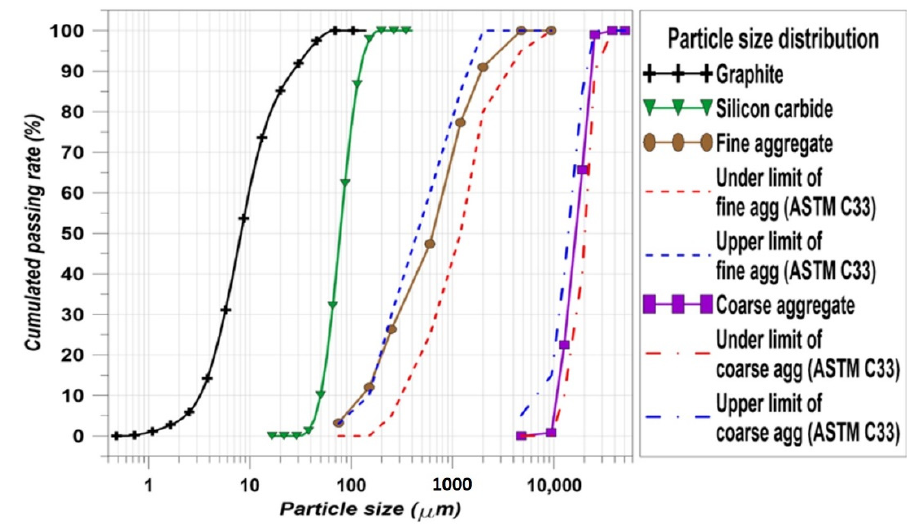
Figure 2. PSDs of the graphite, SiC, fine aggregate, and coarse aggregate.